Question: What does this figure show? Answer in one sentence.
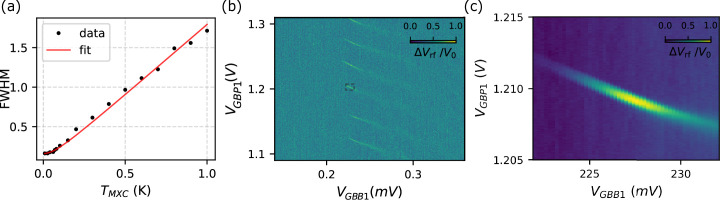
Answer: Tuning the triplet relaxation time and spin parity readout fidelity using the threshold method via a qubit barrier gate. a , \documentclass[12pt]{minimal} \usepackage{amsmath} \usepackage{wasysym} \usepackage{amsfonts} \usepackage{amssymb} \usepackage{amsbsy} \usepackage{mathrsfs} \usepackage{upgreek} \setlength{\oddsidemargin}{-69pt} \begin{document}$${\varGamma }_{{{\rm{T}}}_{-}}^{-1}$$\end{document} Γ T − − 1 and \documentclass[12pt]{minimal} \usepackage{amsmath} \usepackage{wasysym} \usepackage{amsfonts} \usepackage{amssymb} \usepackage{amsbsy} \usepackage{mathrsfs} \usepackage{upgreek} \setlength{\oddsidemargin}{-69pt} \begin{document}$${\varGamma }_{{{\rm{T}}}_{0}}^{-1}$$\end{document} Γ T 0 − 1 show an exponential dependency on barrier gate voltage. For V GTB2 < 212 mV, the dots become too weakly coupled, with an ICT size smaller than voltage resolution, preventing measurement of the PSB. For V GTB2 > 217 mV, the two QDs begin to merge, and the relaxation times of both triplets are below the measurement bandwidth of 3.3 μs (Supplementary Note J ). Inset: tuning of tunnel coupling with barrier gate voltage (see Extended Data Fig. 8 in Supplementary Note I ), where the linewidth saturates at 4 μeV for V GTB2 < 215 mV (grey area) due to thermal broadening with a qubit electron temperature of T e = 40 mK. b , c , Spin parity fidelity varies as a function of the qubit barrier gate. Fidelity is calculated using either the threshold method and simulating the spin distribution via the simple two-state model ( b ) or the HMM, which accounts for a three-state distribution and TLF ( c ). In both cases, the initial distribution is fixed to \documentclass[12pt]{minimal} \usepackage{amsmath} \usepackage{wasysym} \usepackage{amsfonts} \usepackage{amssymb} \usepackage{amsbsy} \usepackage{mathrsfs} \usepackage{upgreek} \setlength{\oddsidemargin}{-69pt} \begin{document}$$p(|{\rm{S}}\rangle )=p(|{{\rm{T}}}_{0}\rangle )=0.25$$\end{document} p ( | S 〉 ) = p ( | T 0 〉 ) = 0.25 and